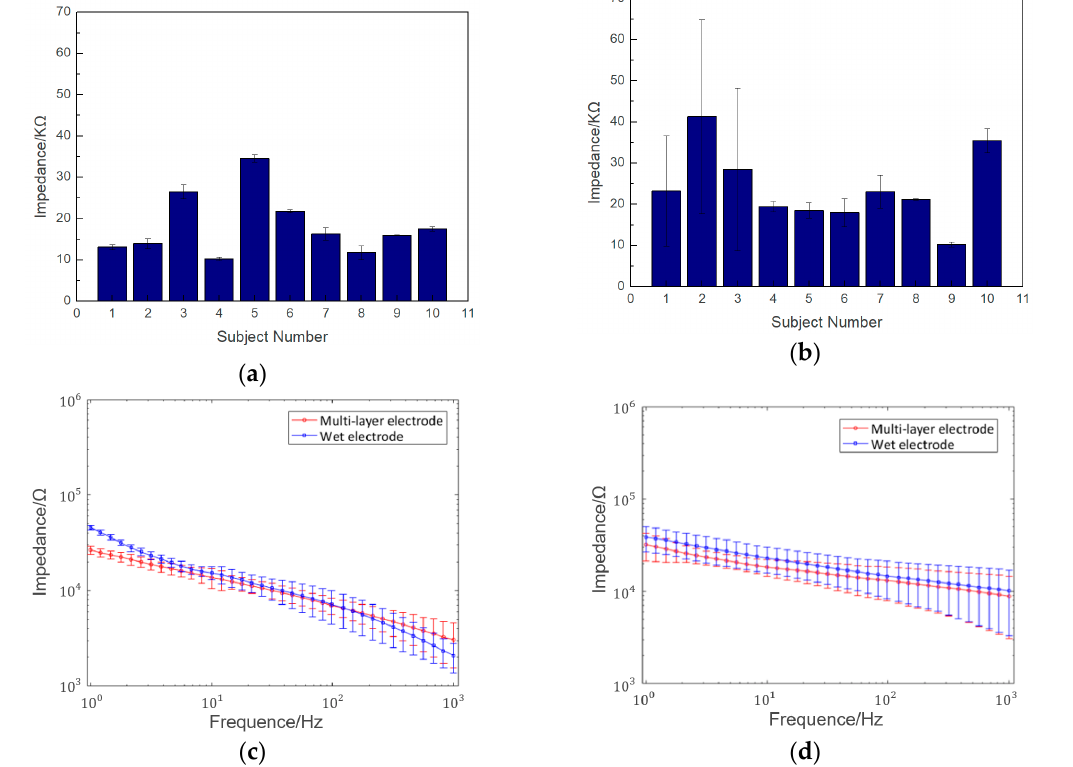
Figure 7. Results of semi ‐ dry electrode–scalp contact impedance experiment: ( a ) impedance of 10 subjects at the forehead (Fpz) at 10 Hz; ( b ) impedance of 10 subjects at the back of the head (Oz) at 10 Hz; ( c ) frequency–impedance spectra comparison of the semi ‐ dry and wet electrodes at the Fpz; ( d ) frequency–impedance spectra comparison of the semi ‐ dry and wet electrodes at the Oz.